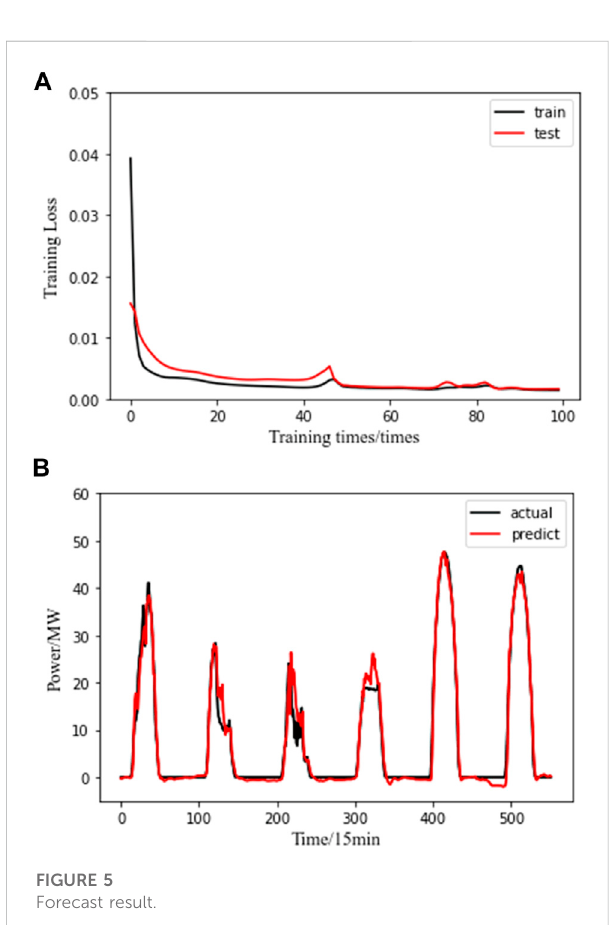
FIGURE 5 Forecast